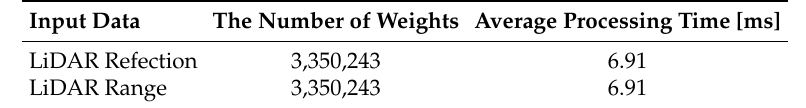
Table 2. Complexity performance results of single-input-based color-image-generation methods in terms of the number of weights and average inference processing